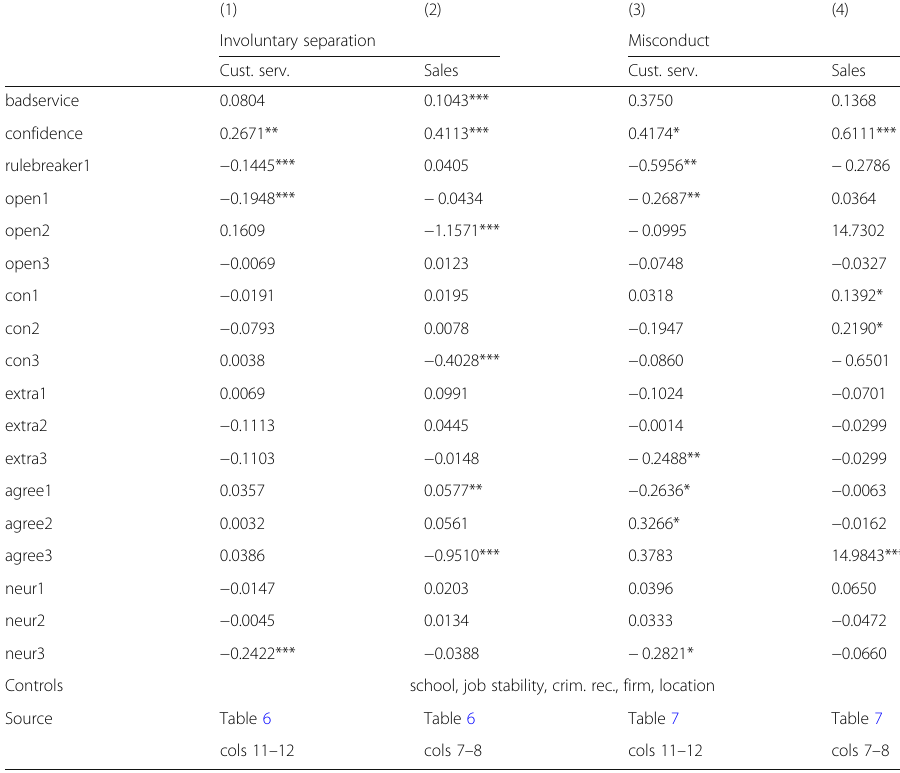
Table 11 Psychometric predictors in different